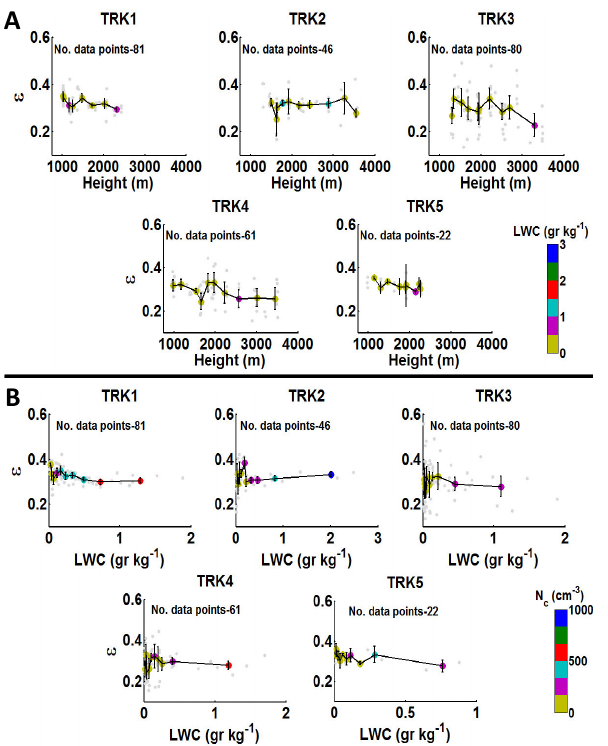
Figure 5. Relative dispersion vs. average radius for (a) the inner cloud data, and (b) the cloud boundaries. Error bars represent the standard error of the average ε for each (cid:104) r (cid:105) level with a confidence level of